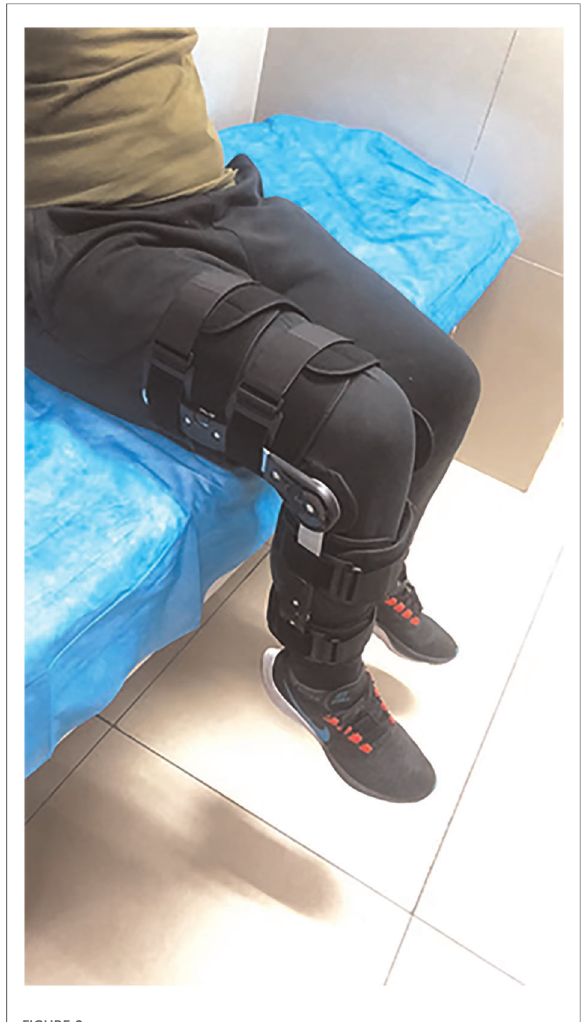
FIGURE 2 The adjustable brace used in the postoperative